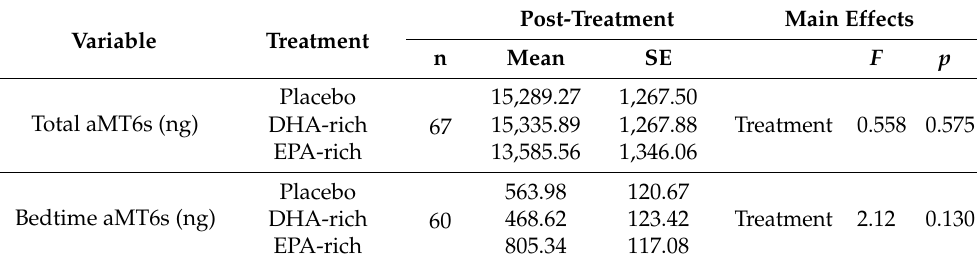
Table 6. Urinary aMT6s for placebo, DHA-rich, and EPA-rich treatment groups. Post-treatment estimated marginal means and standard error (SE) are presented with the F and p values of the main effects from the linear mixed